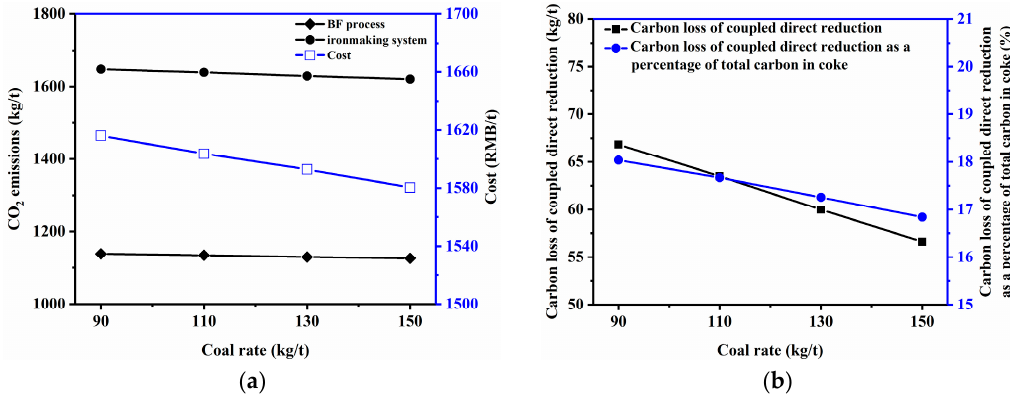
Figure 2. ( a ) Effect of coal rate on cost and CO 2 emissions; ( b ) Effect of coal rate on carbon loss of coupled direct reduction and its percentage of total carbon in coke.